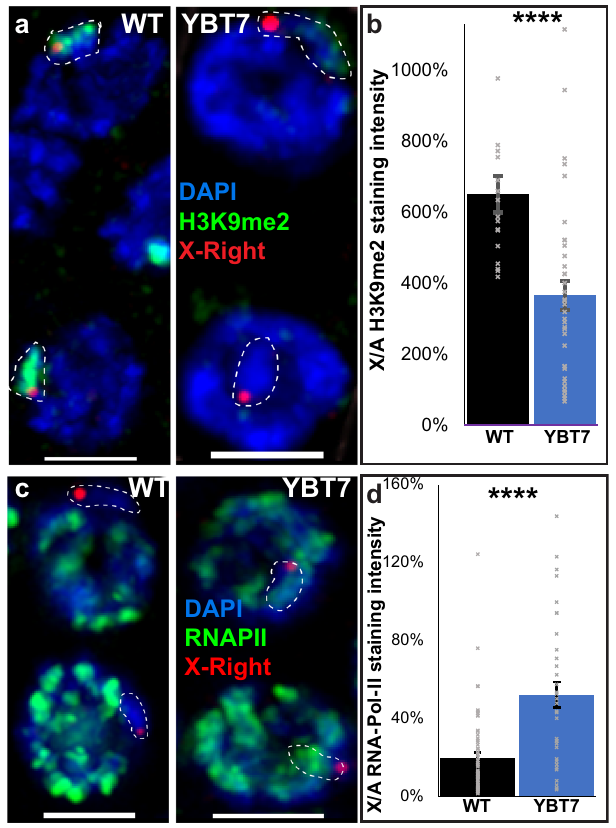
Fig. 3 Bisected X segments are stained with markers associated with transcription during male meiosis. a Mid-pachytene male nuclei stained with DAPI (blue), X-right FISH (red), and antibody against H3K9me2 (green). b Averages ±SEM of the relative H3K9me2 signals in wild-type and YBT7 nuclei on HIM-8-marked body vs. an autosome. n = 17 and 36 nuclei for WT and YBT7 respectively. p value = 0.00003 by the two-tailed Mann – Whitney test. c Mid-pachytene male nuclei stained with DAPI (blue), X-right FISH (red), and antibody against RNAPII (green). d Averages ±SEM of the relative RNAPII signals in wild-type and YBT7 nuclei on HIM-8- marked body vs. an autosome. p value = 0.000004, by the two-tailed Mann – Whitney test. N = 62 and 34 nuclei for WT and YBT7 respectively. **** p < 0.0001, by the two-tailed Mann – Whitney test. Scale bar = 3